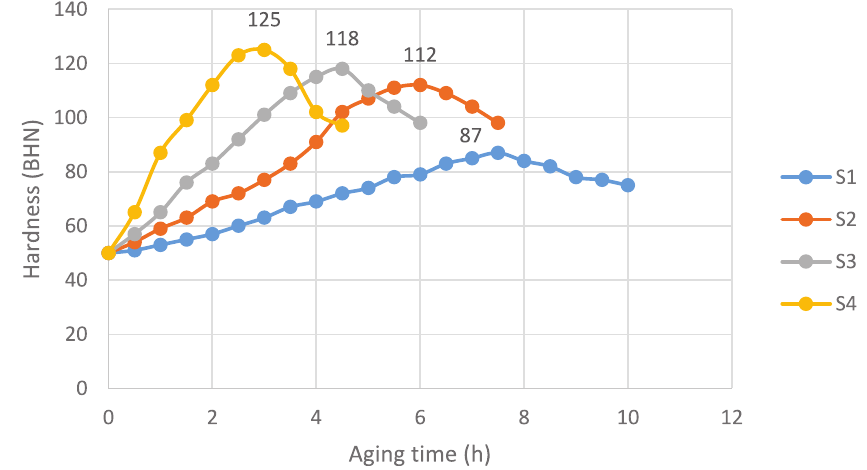
Fig. 9. Variation of hardness for castings at aging at 100 °